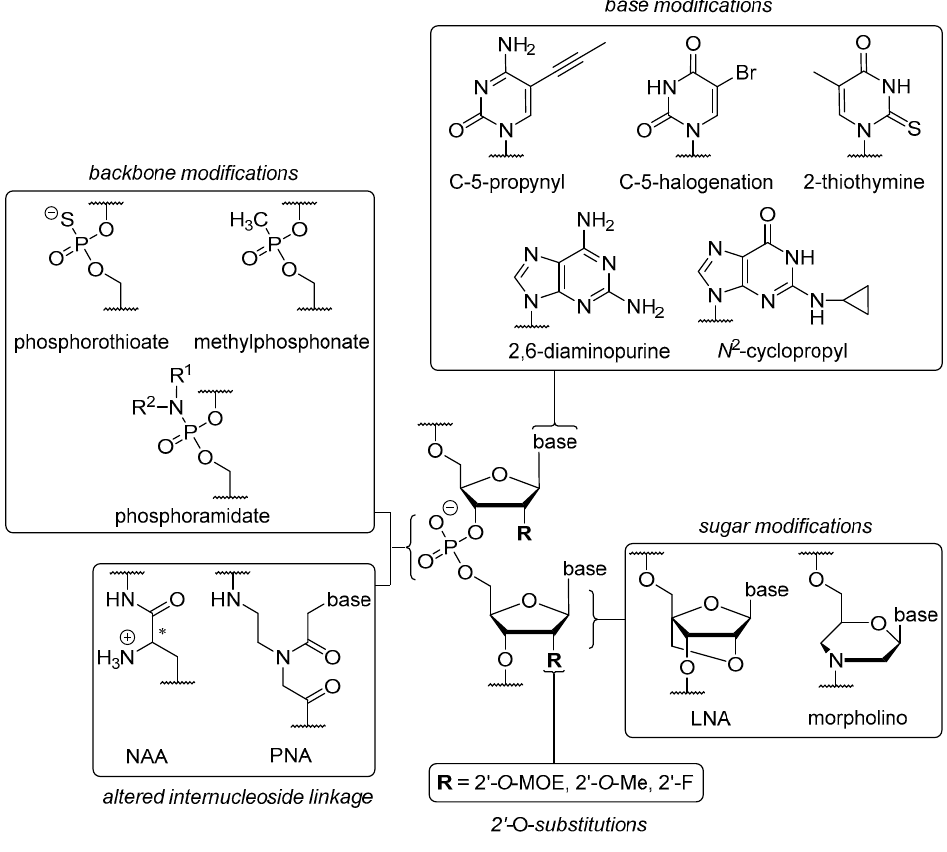
Figure 2. Some selected structural modifications of therapeutic ON with respect to their site of implementation.